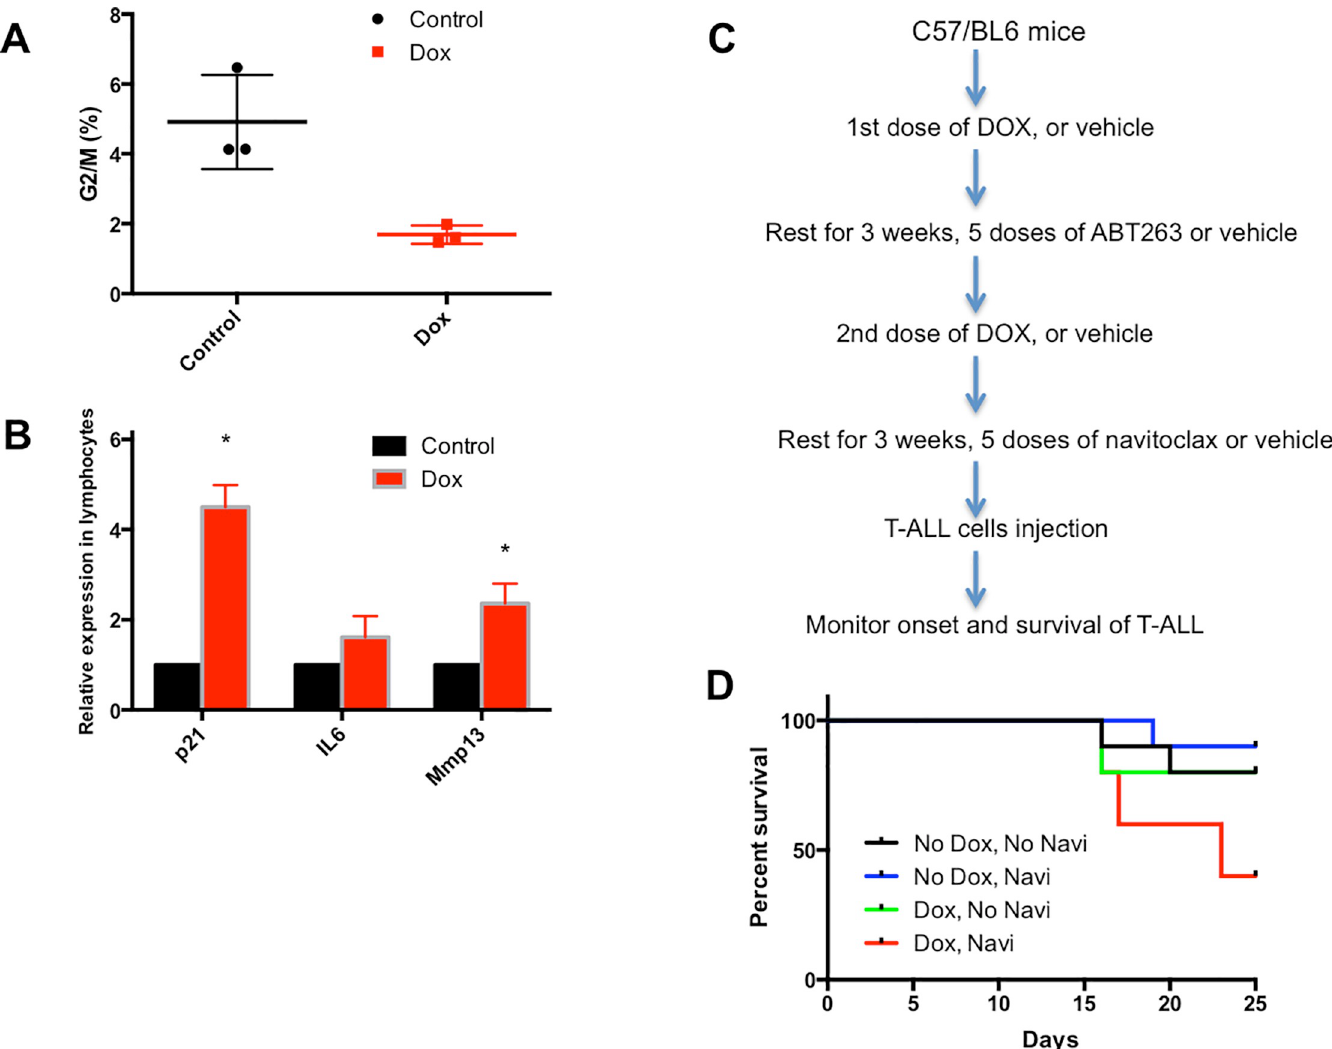
Fig 4. Elimination of senescent cells by senolytic drug (ABT263, also known as Navitoclax) promotes T-ALL progression. (A) Percentages of G2/M phase cells in the peripheral blood of control or doxorubicin-treated C57/BL6 mice (Control: n = 3; Dox: n = 3. p < 0 . 05 by two-tailed unpaired t-test) . (B) Relative expression of senescent marker mRNAs specific for p21 , IL6 , and Mmp13 in blood cells from control or doxorubicin-treated mice. Control: n = 3; Dox: n = 4. � p < 0 . 01 . (C) Schematic of experimental procedures for (D). (D) Kaplan-Meier survival curve of C57/BL6 mice receiving doxorubicin and navitoclax (50 mg/kg). The 1 st cohort (Black line, No Dox, No Navi) only received vehicle (n = 10); the 2 nd cohort (Blue line, No Dox, Navi) received navitoclax only (n = 10); the 3 rd cohort (Green line, Dox, No Navi) received doxorubicin only (n = 10). The 4 th cohort (Red line, Dox, Navi) received both doxorubicin and navitoclax (n = 10). Logrank test for trend, p < 0 . 05 .